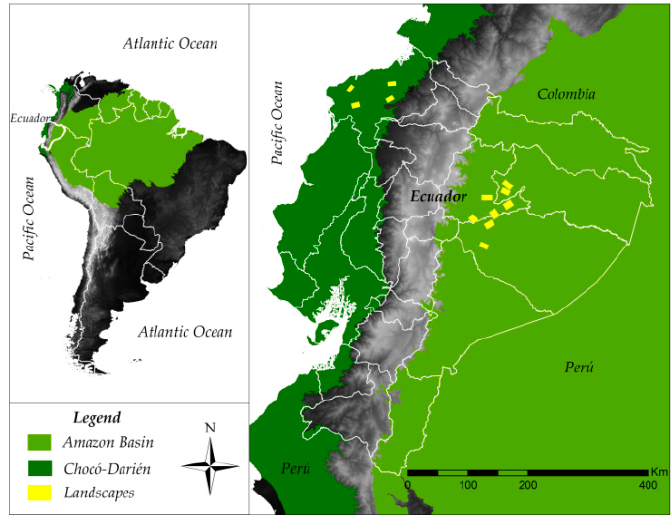
Figure 2. Location of sites selected for our study in the Central Amazon and the Chocó-Darién of Ecuador.